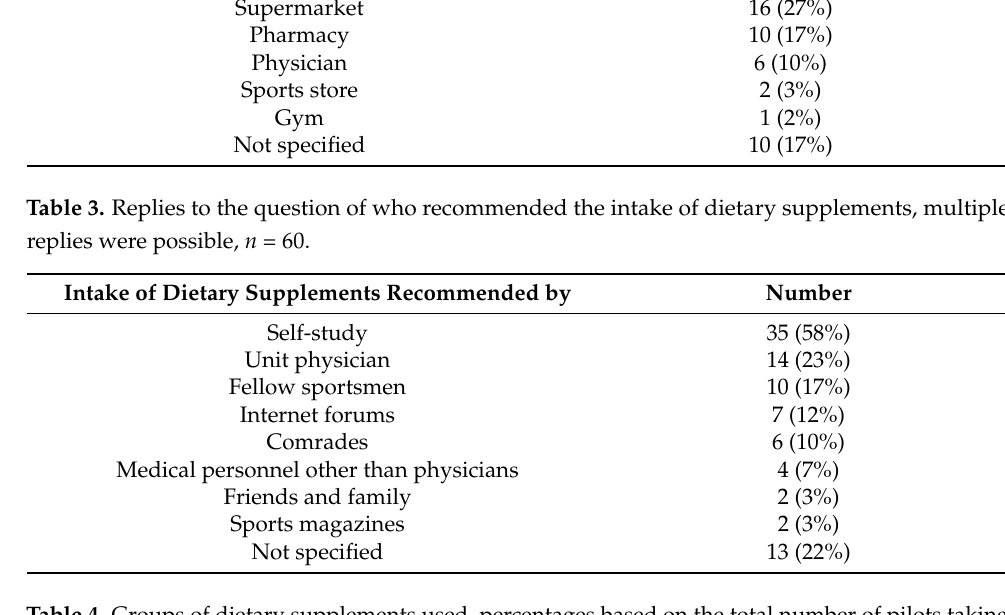
Table 4. Groups of dietary supplements used, percentages based on the total number of pilots taking dietary supplements on a regular basis (median every day), sorted by number (descending), n =